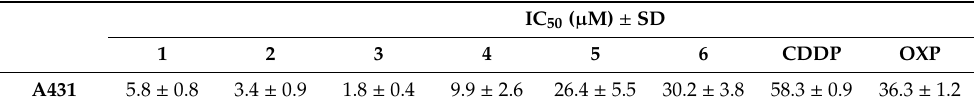
Table 6. Cytotoxicity towards human A431 cancer cell spheroids. Spheroids were treated for 72 h with increasing concentrations of tested compounds. The growth inhibitory e ff ect was evaluated by APH. IC 50 values were calculated by 4-parameters logistic model ( p < 0.05). SD = standard deviation. CDDP: cisplatin, OXP: oxaliplatin.